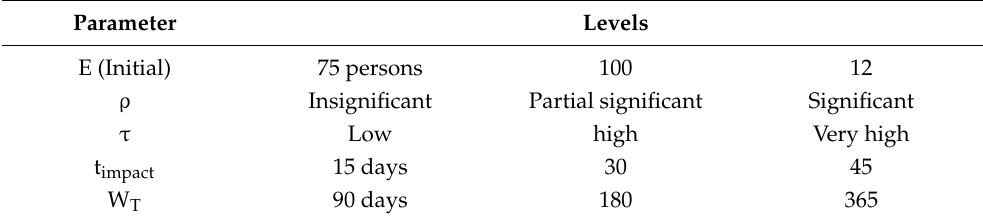
Table 2. Variables and their corresponding levels chosen for refining the model.